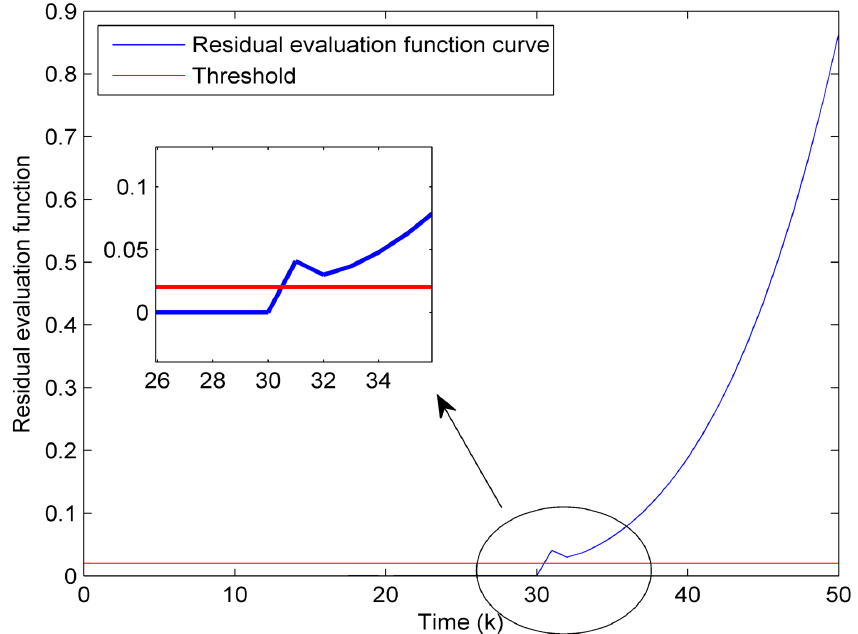
Figure 3. The residual evaluation function responses of the system with zero ˜ d k for an incipient fault (Equation (32)).